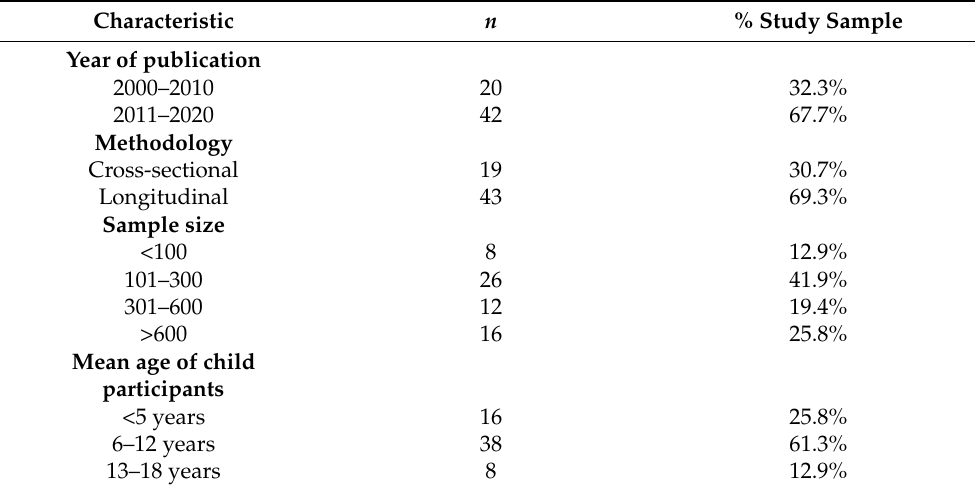
Table 1. Descriptive information of studies included in the review ( n =